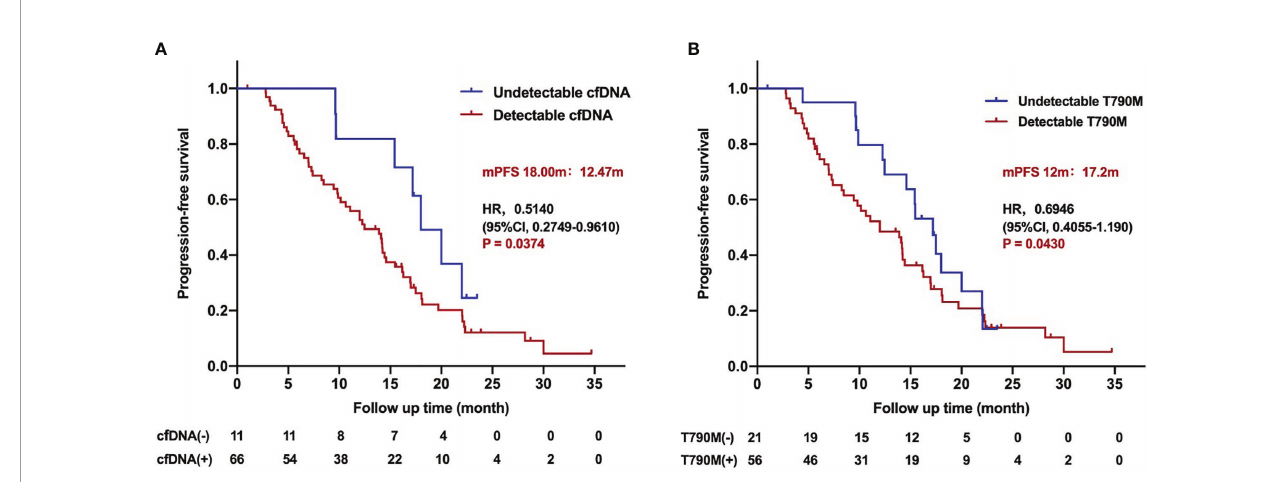
FIGURE 3 | Progression-free survival for patients treated with the third-generation EGFR TKIs according to pretreatment cfDNA and T790M level. (A) Kaplan – Meier analysis strati fi ed by cfDNA level. (B) Kaplan – Meier analysis strati fi ed by T790M level.